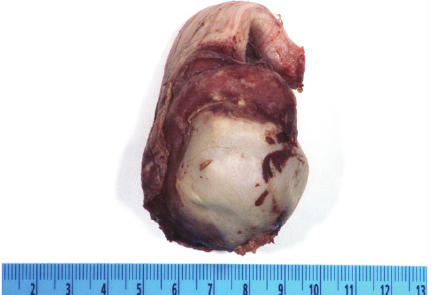
Figure 3: Orchiectomy specimen demonstrating indurated epi- didymis and spermatic cord with infarcted